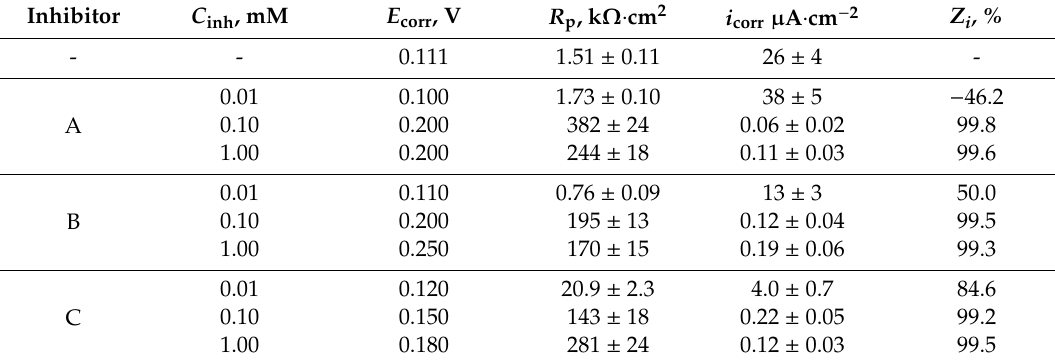
Table 2. Open circuit potential E corr , polarization resistance R p , corrosion current density i corr , and degree of protection of brass Z i , in 10 mM NaCl solutions with various 3-mercaptoalkyl derivatives of 5-amino-1 H